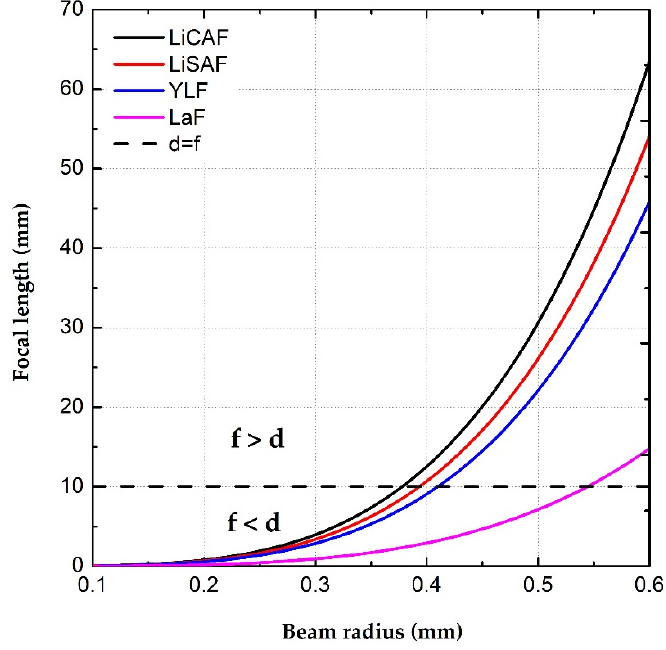
Figure 6. Focal length as a function of the beam radius. The dashed line indicates the limit in the laser material’s length that defines whether the focal point occurs inside or outside the material. It also defines the lower limit on the size of the excitation beam.